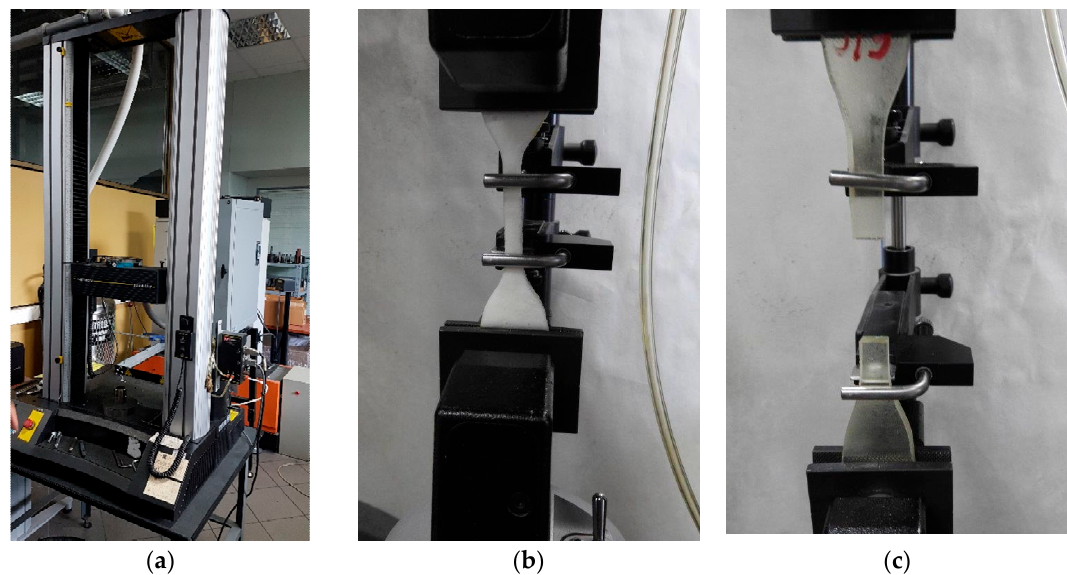
Figure 2. Resin testing according to [16]—axial tensile test: ( a ) view of the strength testing machine—test stand, ( b ) view of the shaped resin elements, the so-called “oars”, placed in the clamps and ( c ) view of the completed test at the moment of breaking of the resin specimen.